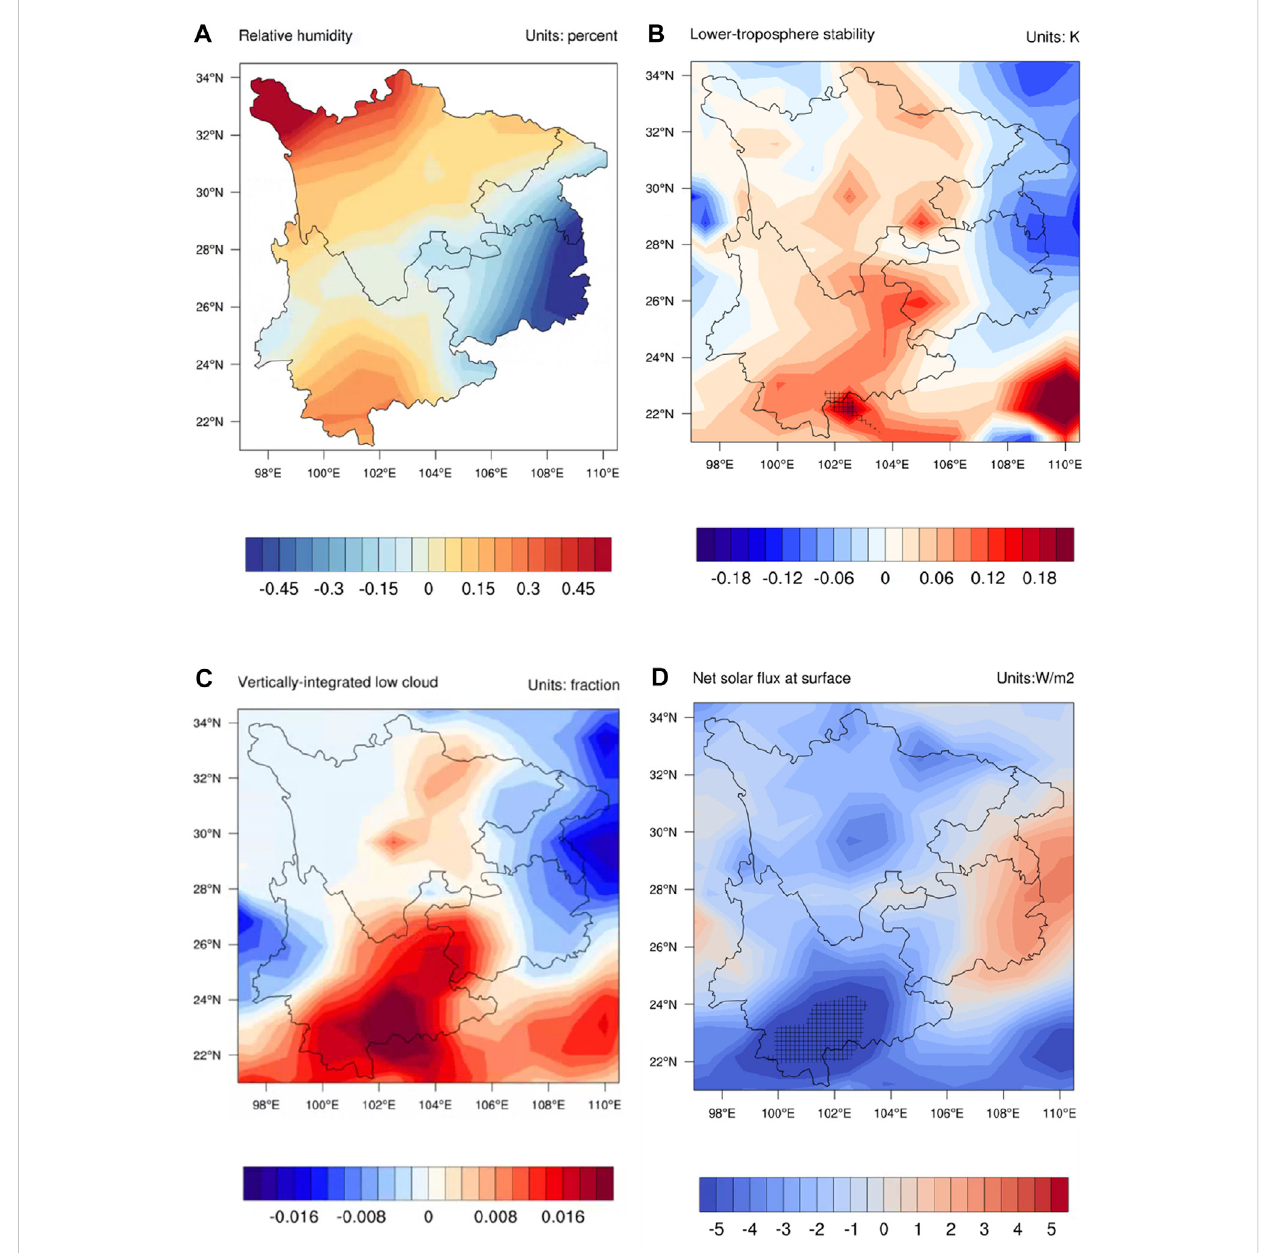
FIGURE 10 Effects of AHR on southwest China in the boreal summer (JJA) from 1992 to 2013: (A) relative humidity (unit: percent); (B) lower-troposphere stability (LTS) (unit: K); (C) low clouds (unit: fraction); (D) thenetsolar radiation fl uxatthesurface(unit: W m -2 ).The plussigns in fi gure denote thechange is statistically signi fi cant at the 0.05